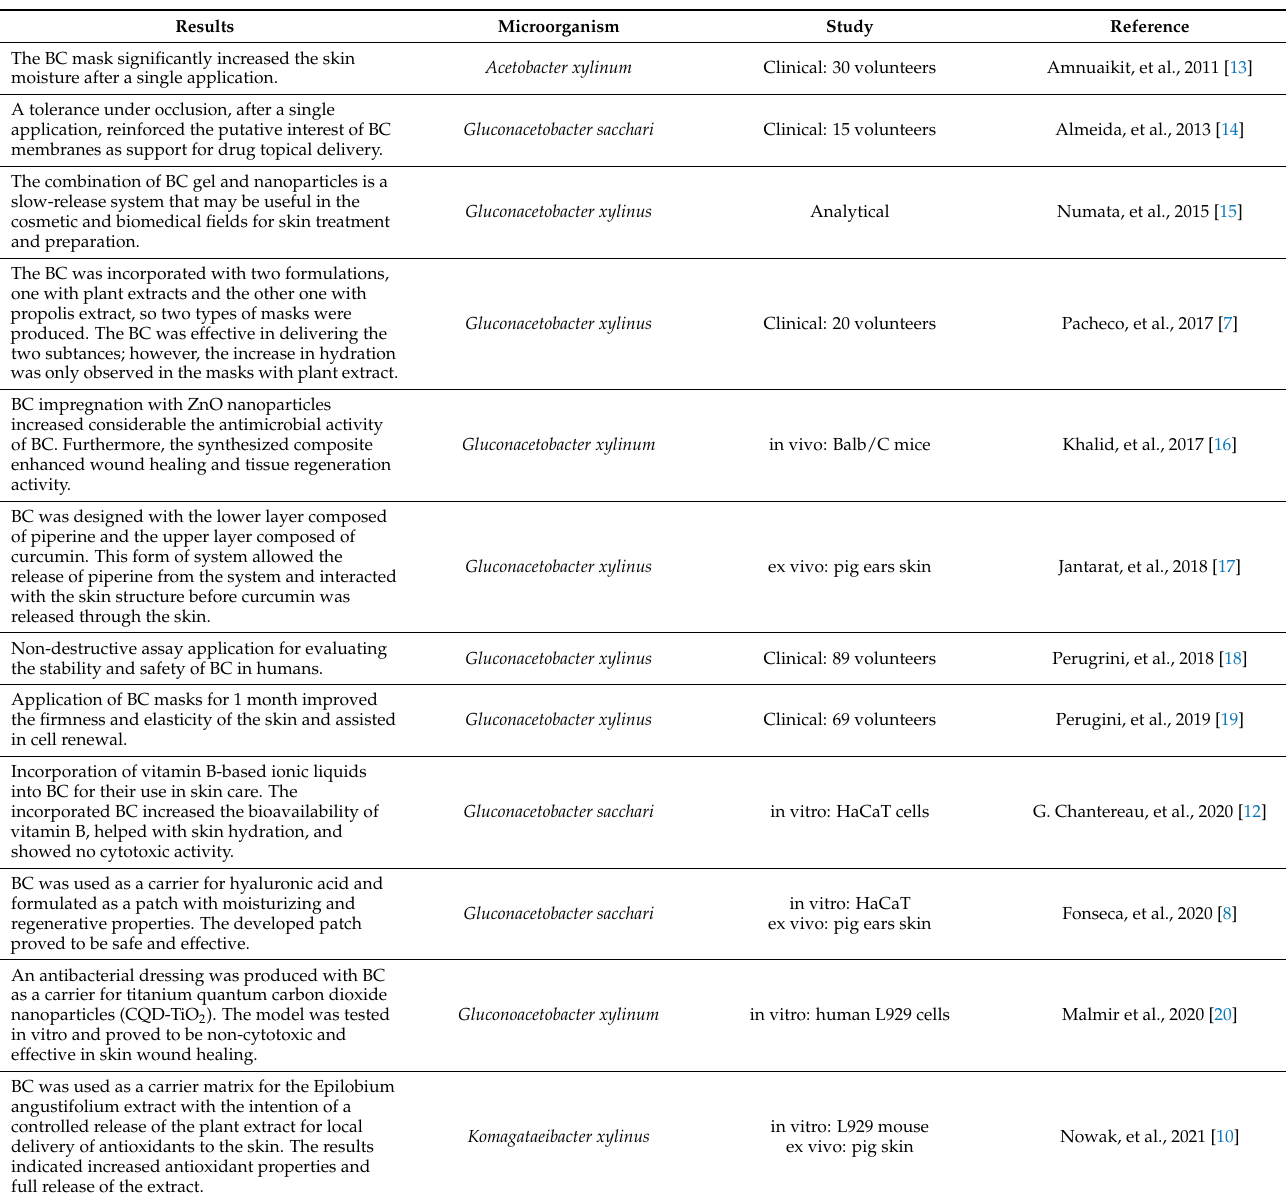
Table 1. Data demonstration collected in the studies on bacterial cellulose in cosmetics selected by the aforementioned exclusion